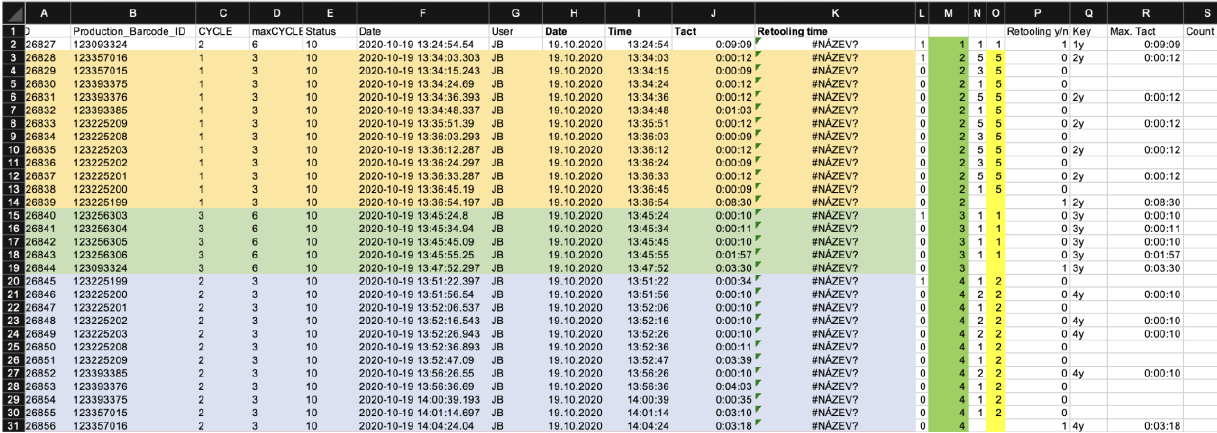
Figure 4. An example of the machine data sorted by the column “CYCLE”.